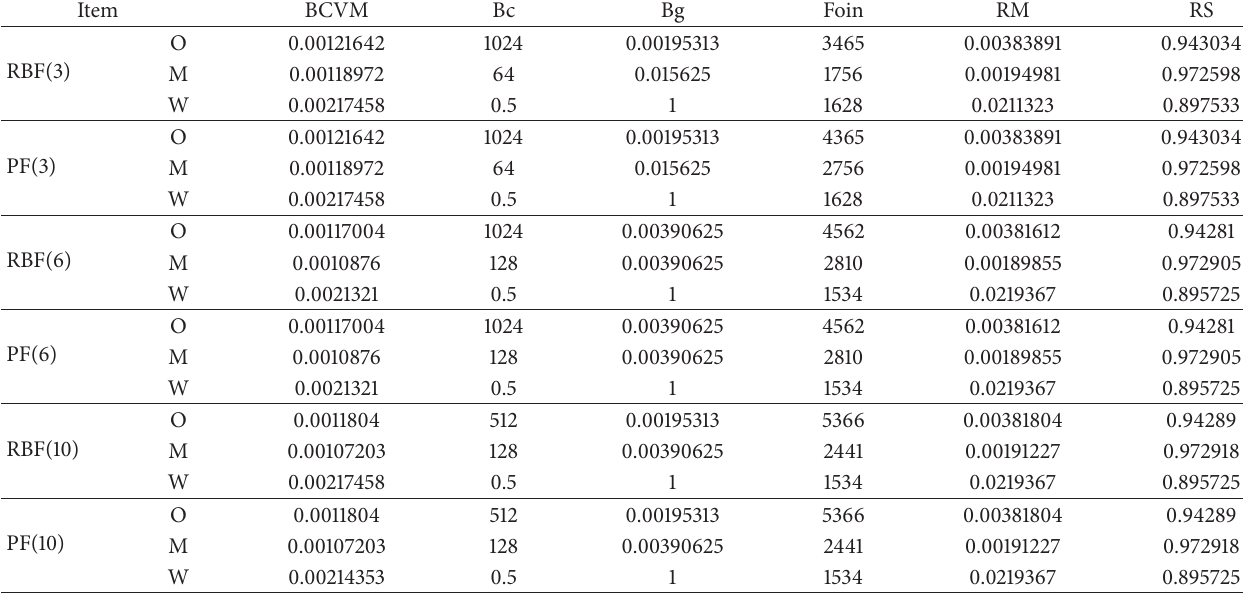
Table 3: Simulation results refer to multiscale SVR.